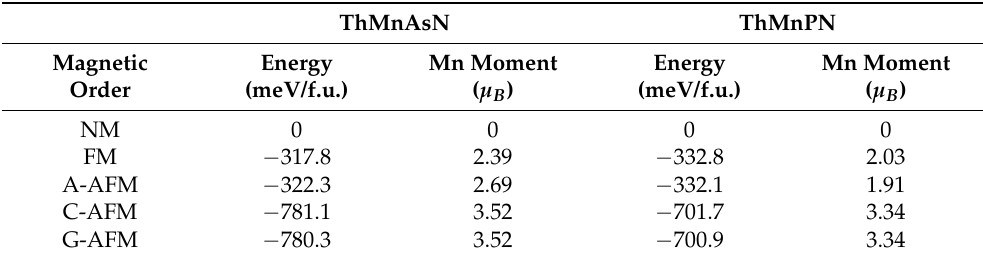
Experimental values of the Mn moment of ThMnAsN and ThMnPN were 3.41 µ B and 3.60 µ B , respectively, at 4 K. We present our calculated density of states (spin-polarized) of ThMnAsN and ThMnPN in Figures 2 and 3, respectively, for all four magnetic spin arrangements.